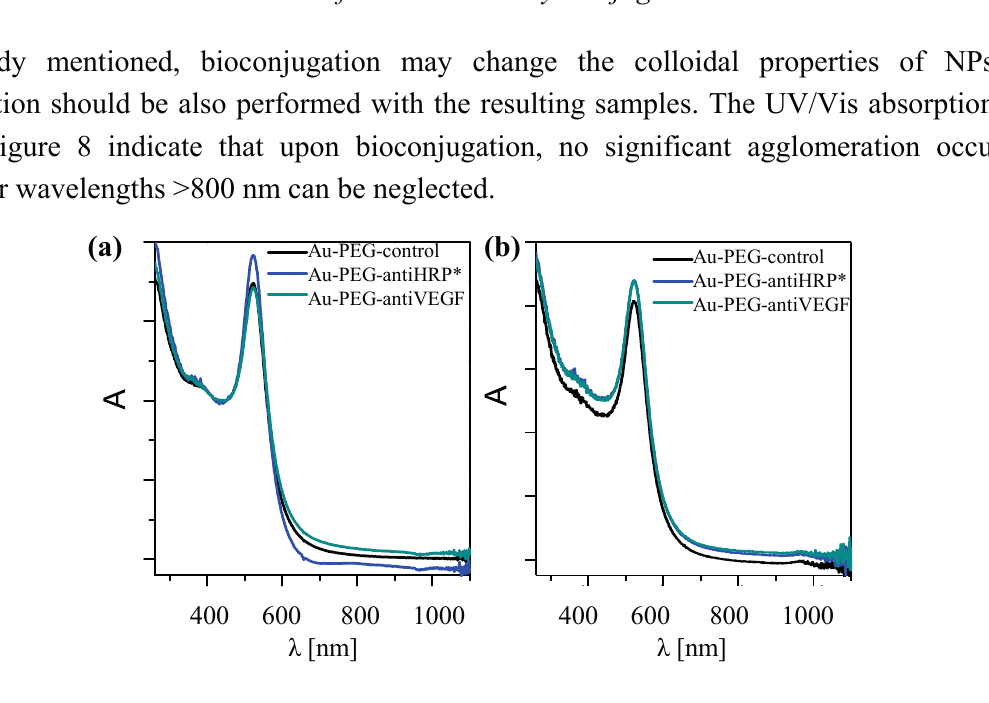
Figure 8. Normalized UV/Vis spectra of the NP-antibody conjugates. ( a ) Au-PEG-control, Au-PEG-anti-HRP*, and Au-PEG-anti-VEGF* NPs; ( b ) Au-PEG-control,